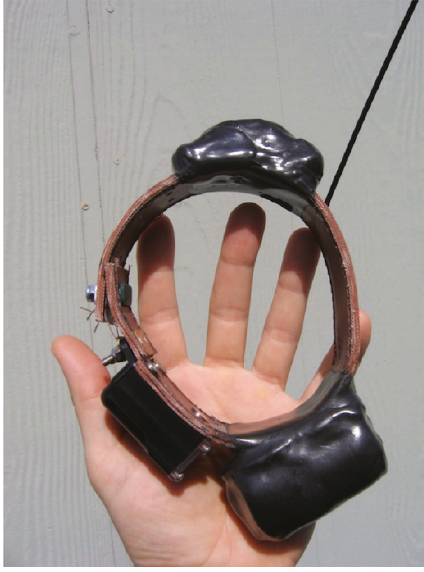
Figure 3: Deployed CARNIVORE node. This collar was deployed on a mountain lion. The CARNIVORE electronics are above, D- cell battery and VHF beacon are lower right, and a timed dropo ff (SirTrack [17]) is lower left. VHF antenna can be seen exiting the collar upper right. The VHF beacon and dropo ff use separate power supplies from the CARNIVORE platform. Components were assembled by Telemetry